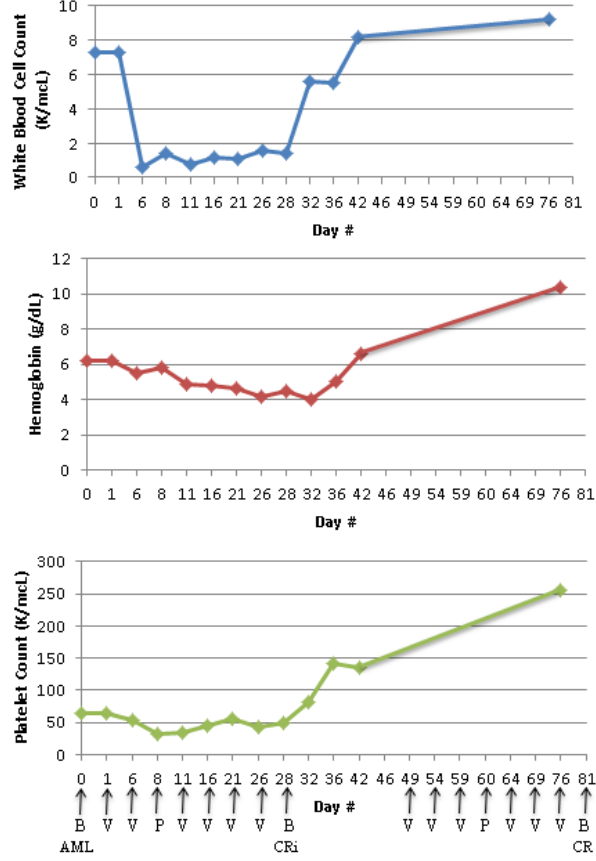
Figure 2. White blood cell, hemoglobin, and platelet counts from diagnosis throughout two cycles of chemotherapy regimens; Arrows indicate the days of bone marrow biopsy (B), receiving vincristine (V), or pegasparaginase (P).